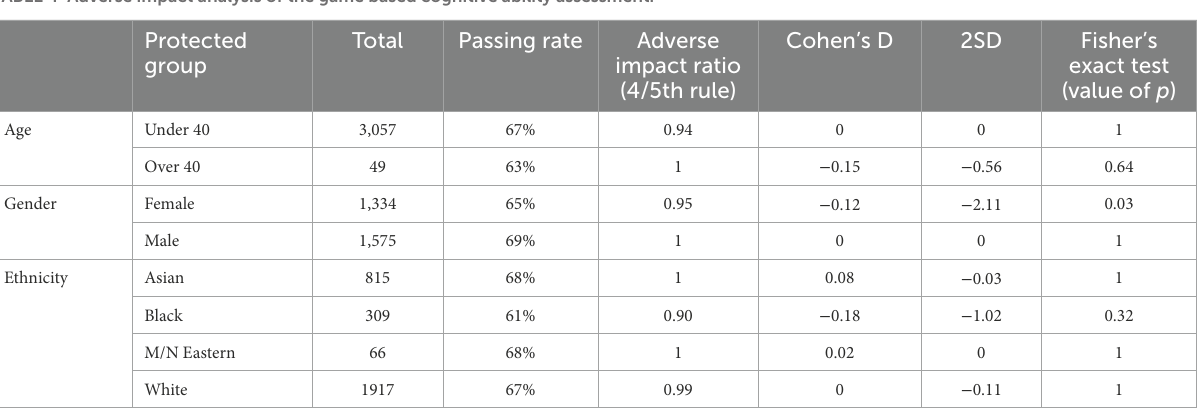
TABLE 4 Adverse impact analysis of the game based cognitive ability